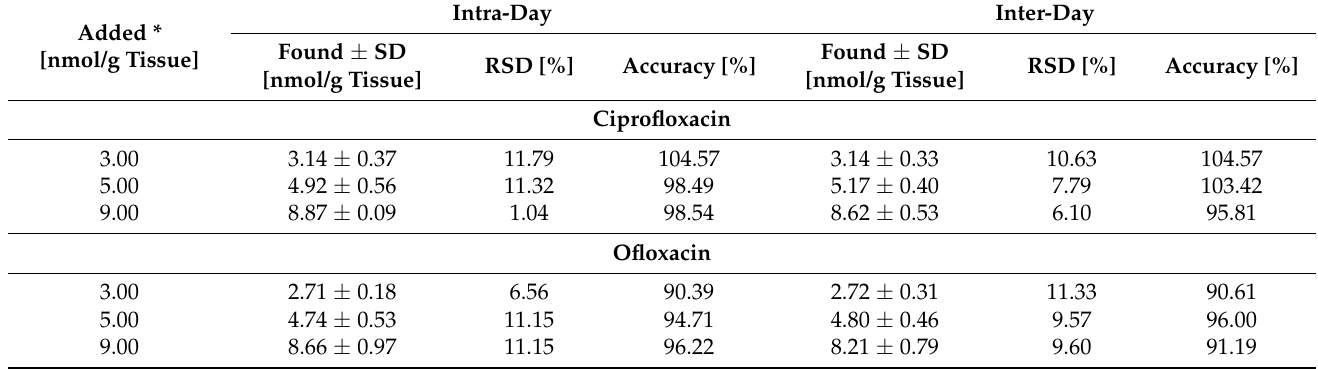
Table 1. Validation